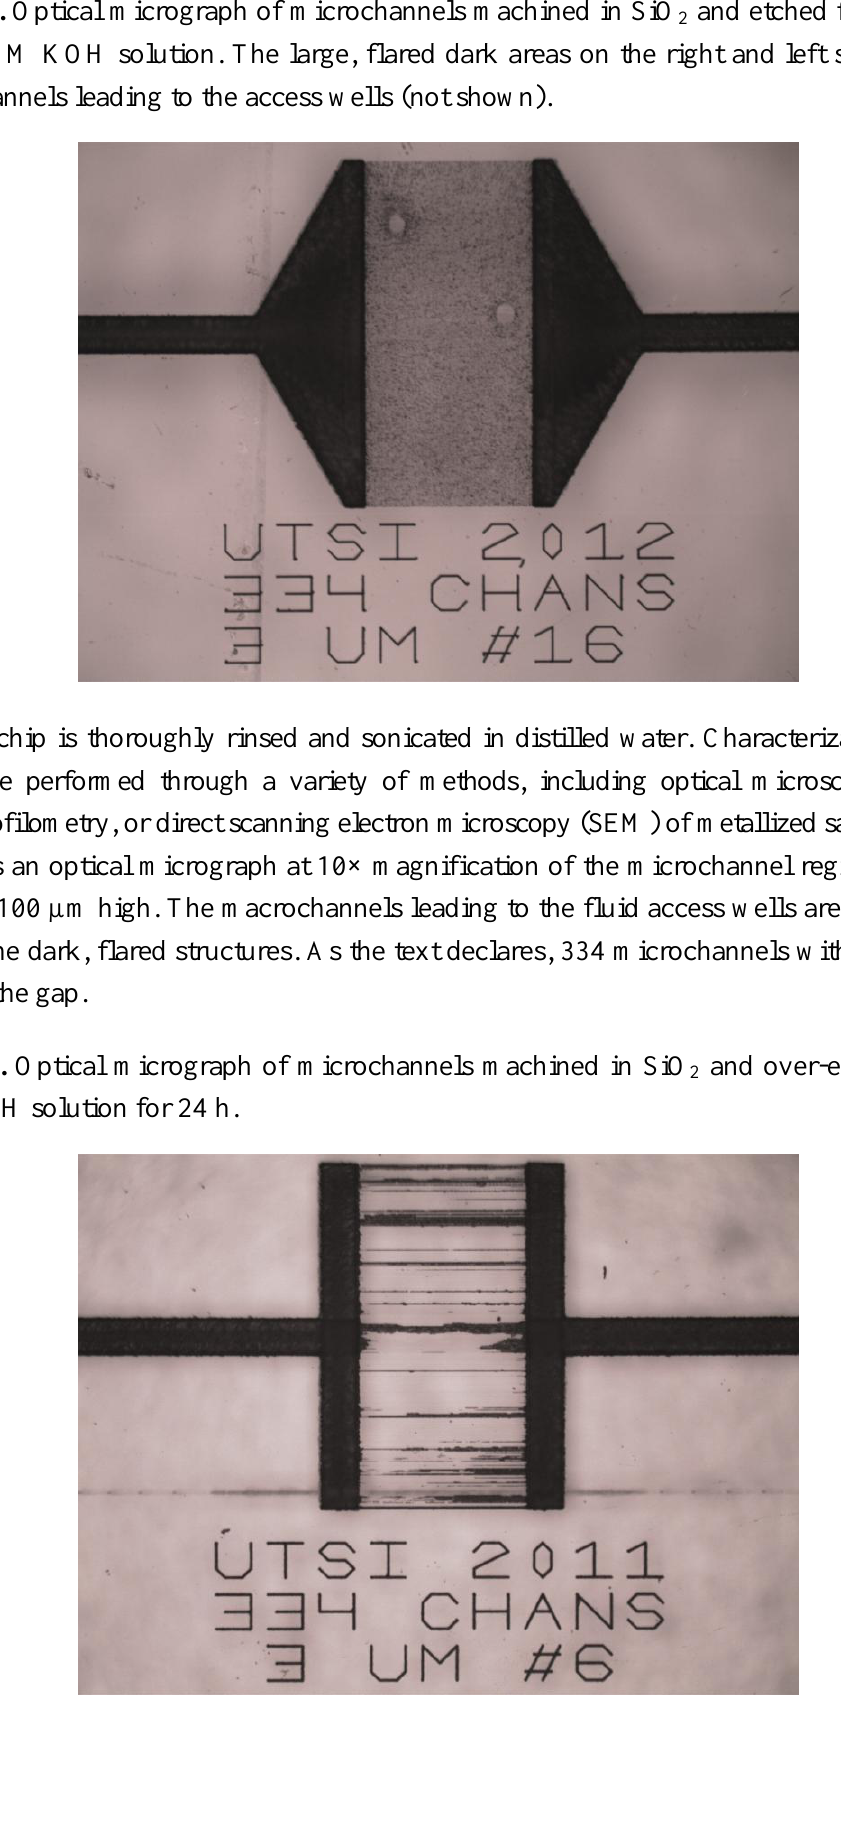
and etched for one hour 2